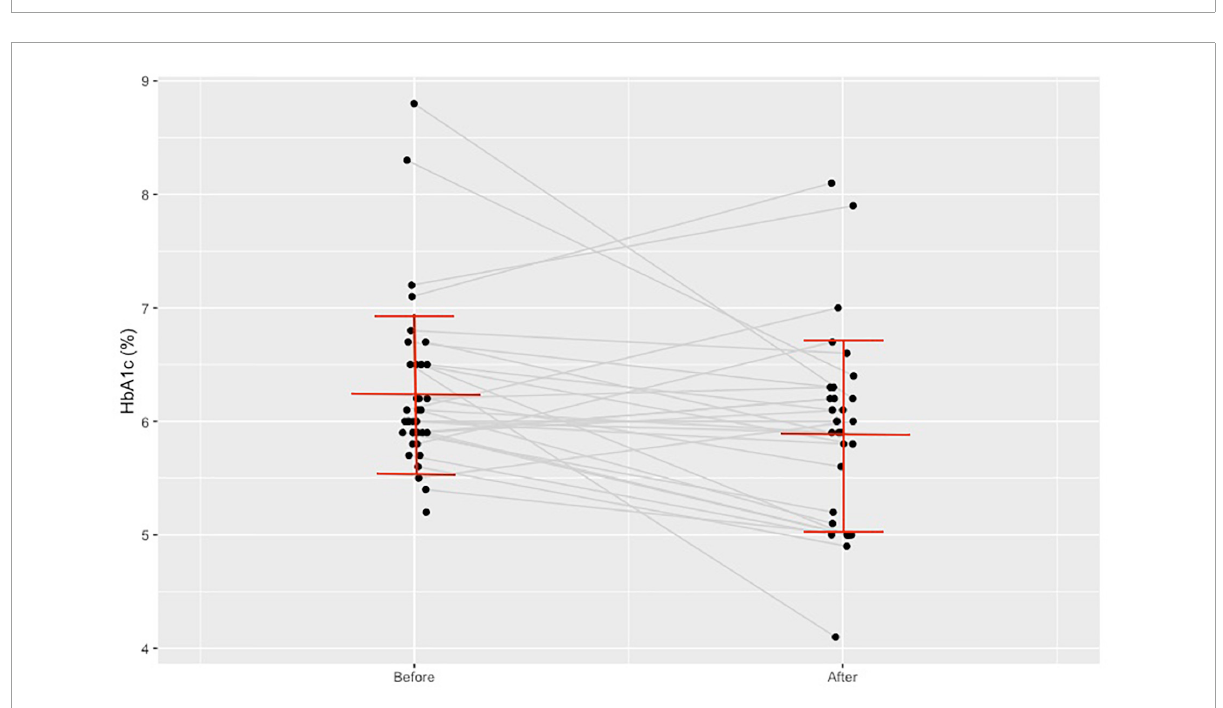
FIGURE4 Change in glycated hemoglobin A1c level before and after the training